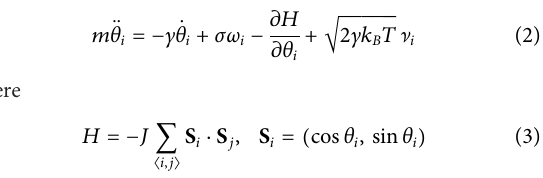
FIGURE 1 Snapshots for T = 0.2, (A) σ 2 = 0 and (B) σ 2 = 0.1. The phase of each oscillator is represented by a color scale. Vortices (antivortices) are represented by circles